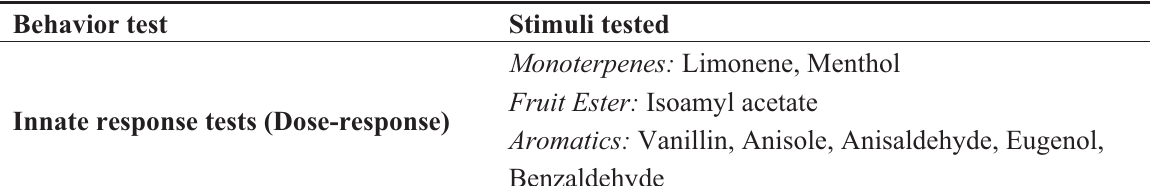
Table 1. Overview of experiments